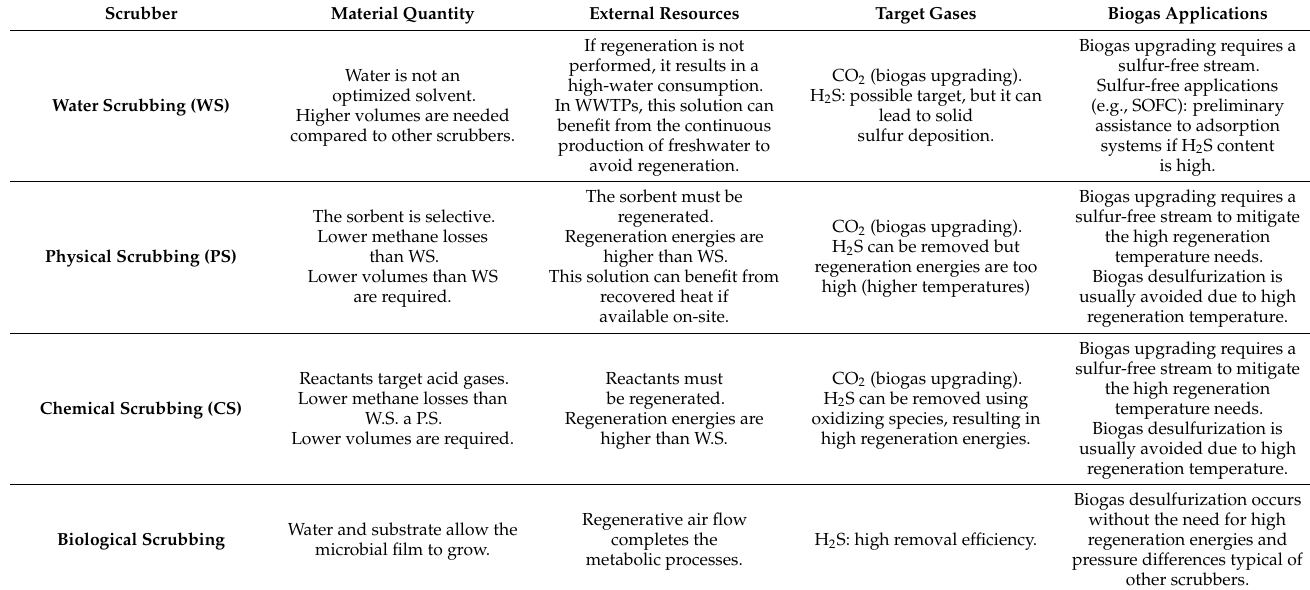
Table 7. Comparison of the main aspects affecting the use of Water, Organic, Chemical, and Biolog- ical Scrubbers.